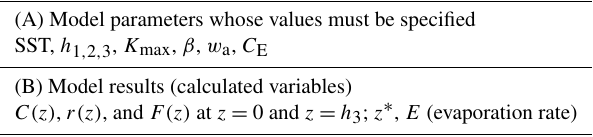
Table 2. Model parameters, results, and diagnostics. (A) Model parameters whose values must be specified